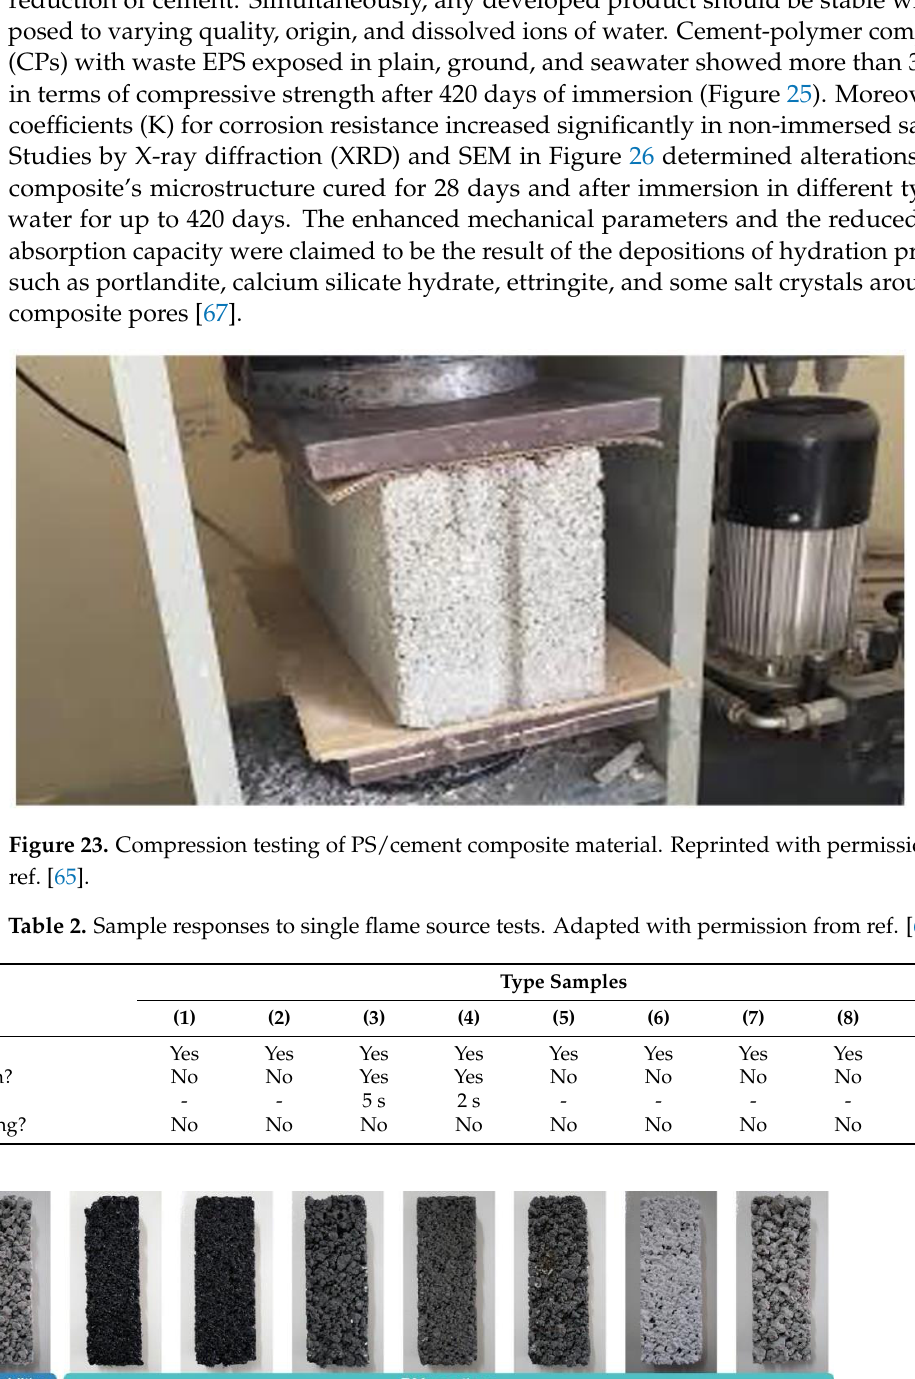
Figure 22. Exposed surfaces of the concrete disc ( a ) without WEEE (Control mix) and ( b ) with 30% WEEE (PC-Blend-30). Reprinted with permission from ref. [64].